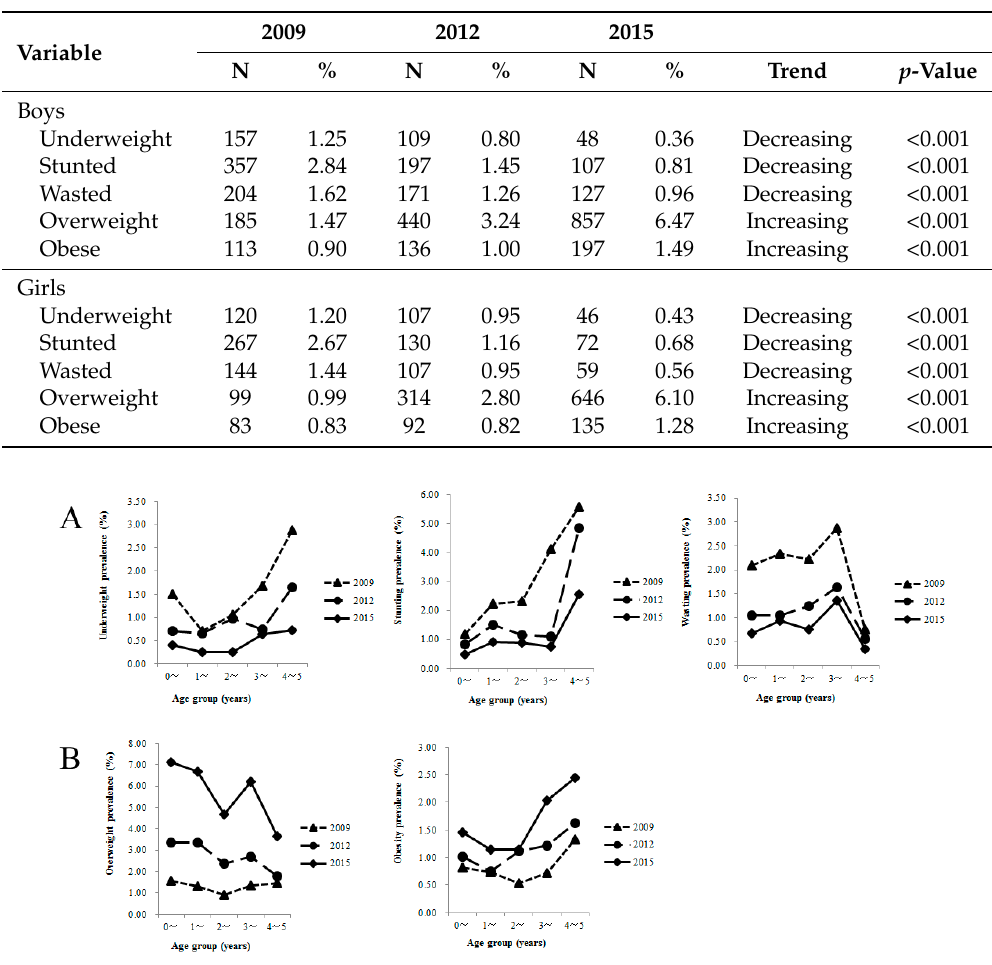
Figure 1. ( A ) Prevalence of underweight, stunted, and wasted children aged 0–5 years old in Xiamen; ( B ) Prevalence of overweight and obese children aged 0–5 years old in Xiamen.